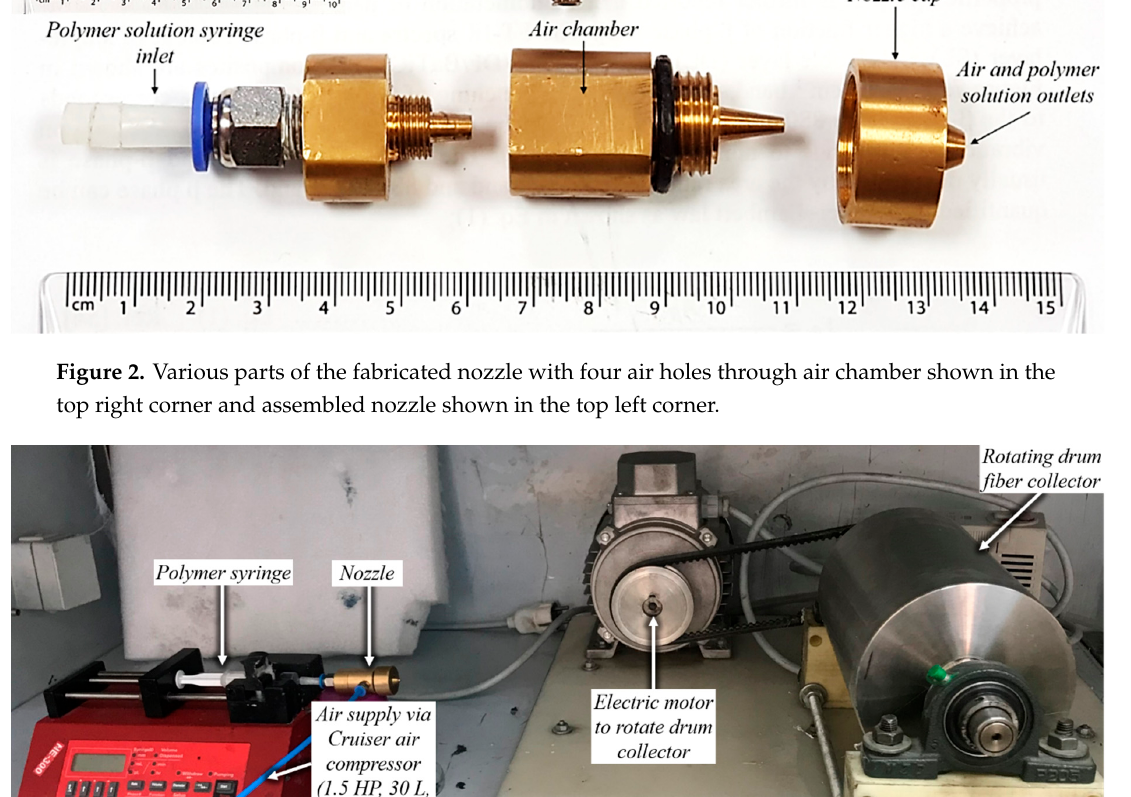
Figure 3. SBS setup for the production of polyvinylidene fluoride (PVDF) fibres.